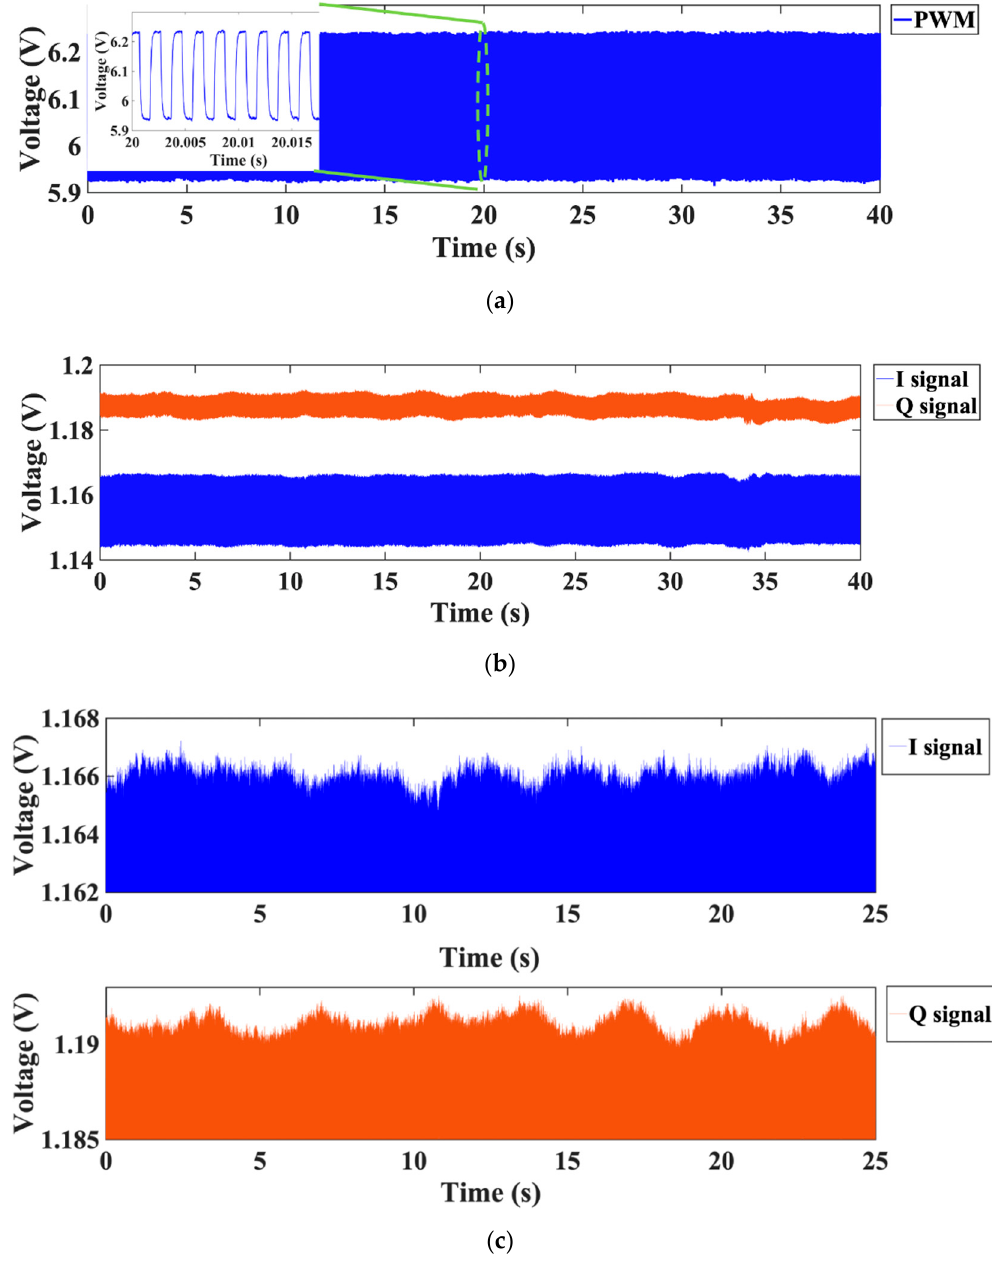
Figure 21. ( a ) Measured PWM control signal; ( b ) measured time domain I/Q signals and ( c ) their zoomed-in view of the target located at the distance of 0.65 m [51].